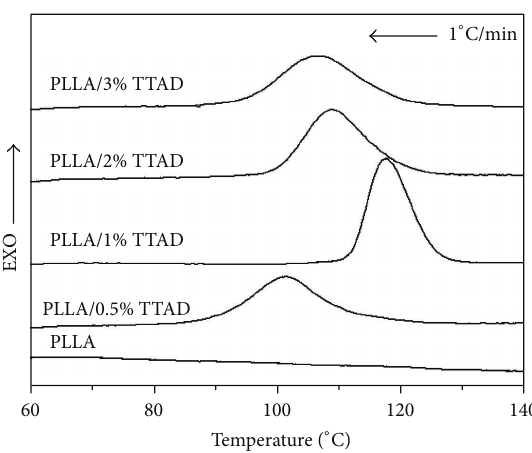
Figure 4: DSC curves of nonisothermal crystallization of PLLA/TTAD at a cooling rate of 1 ∘